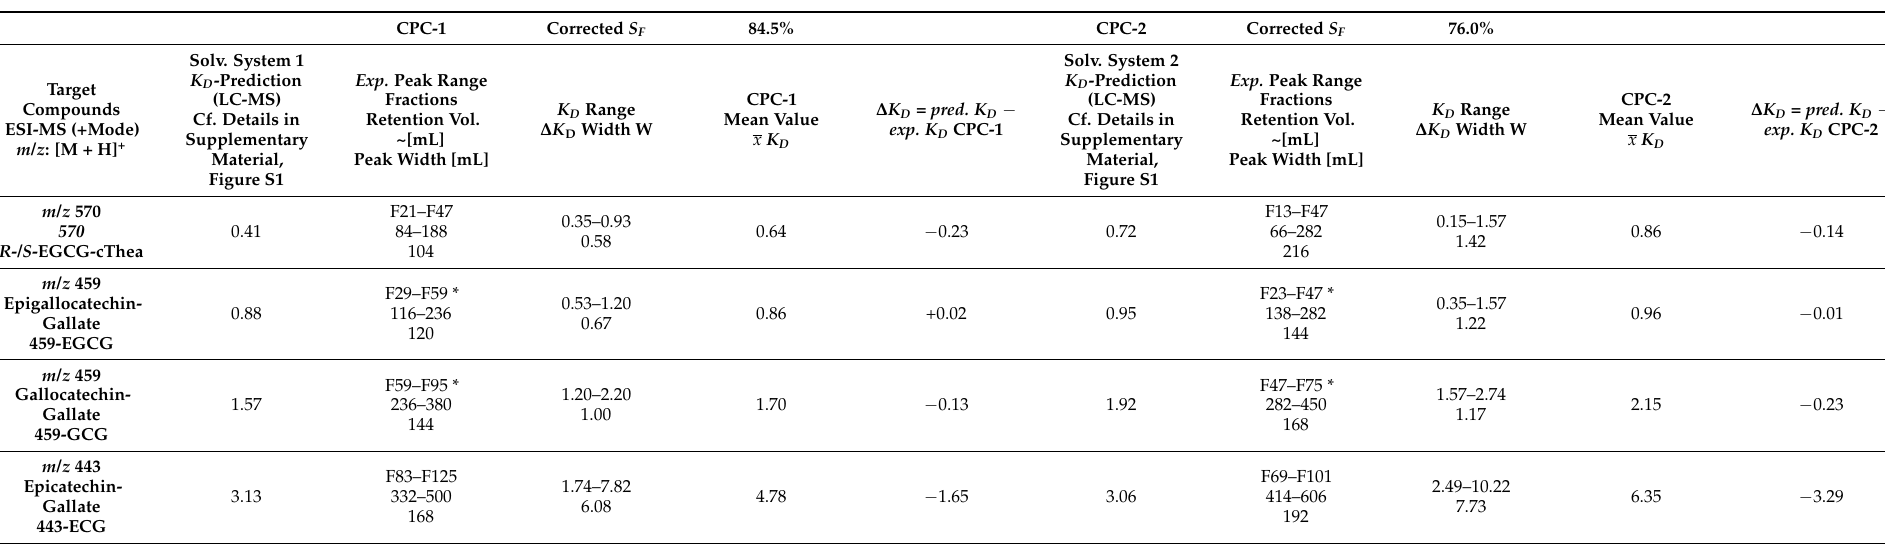
Table 1. Target compound specific K D -values: LC-ESI-MS predicted solvent system K D -values vs. experimental CPC values determined by off-line ESI-MS injection profiling. CPC-1